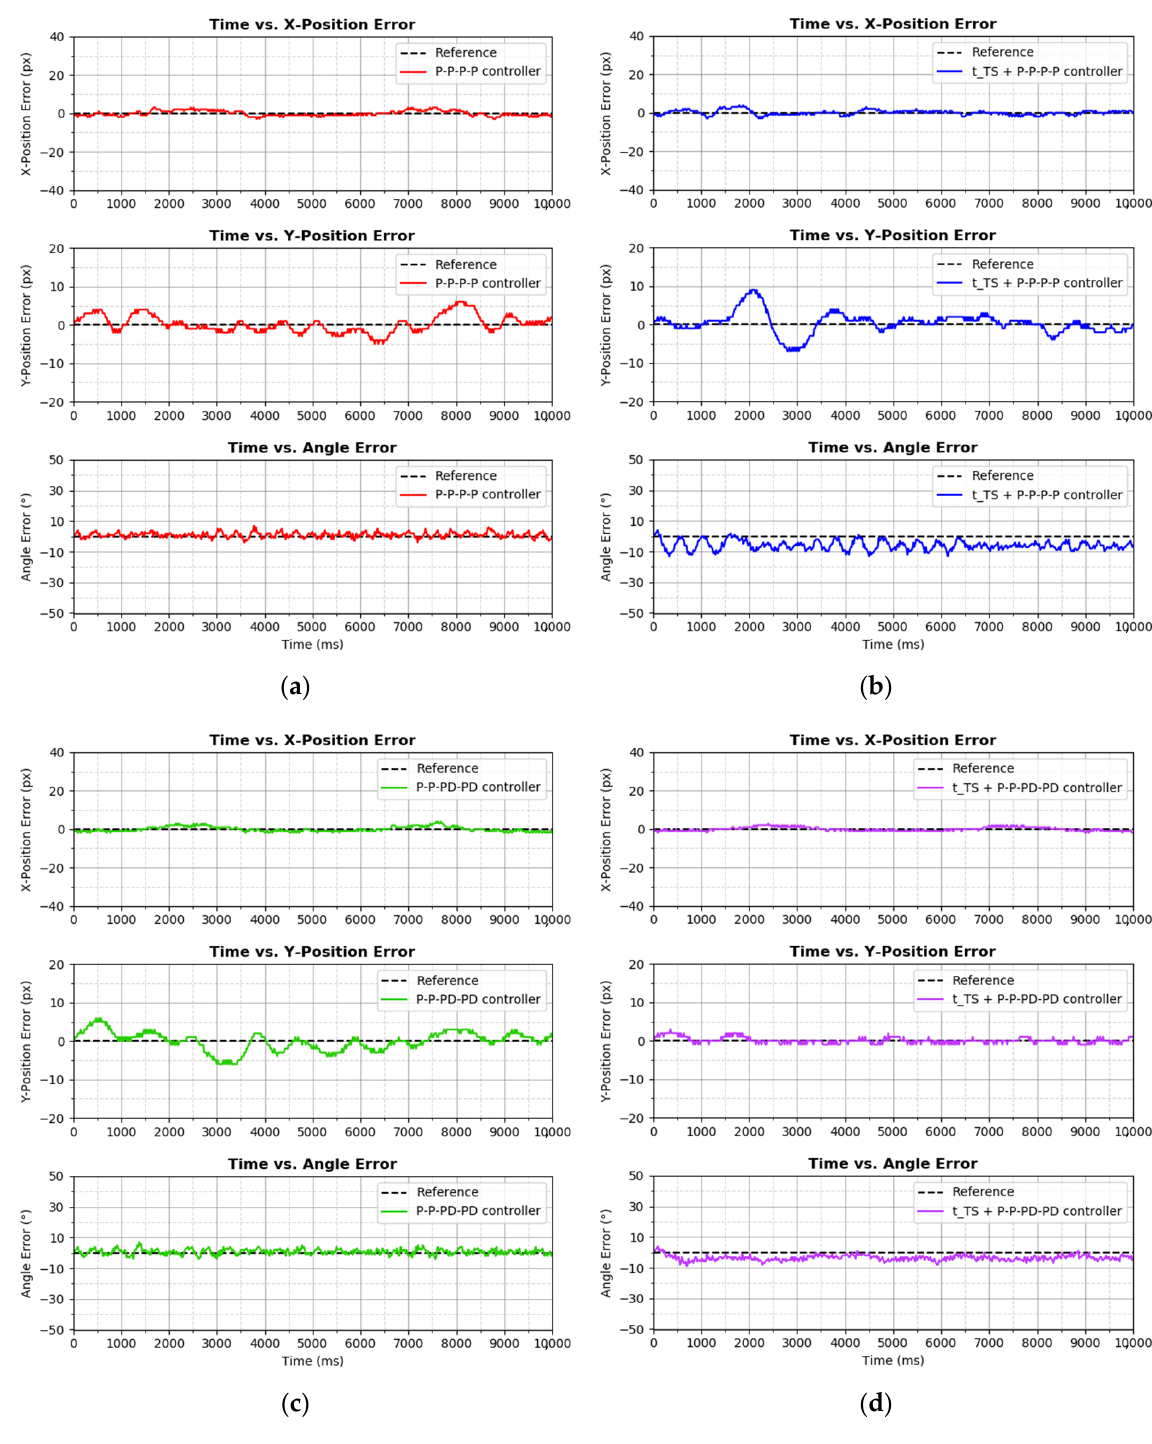
Figure 22. 8-shaped trajectory tracking performance by ( a ) P–P–P–P controller, ( b ) t TS + P–P–P–P controller, ( c ) P–P–PD–PD controller, and ( d ) t TS + P–P–PD–PD controller on